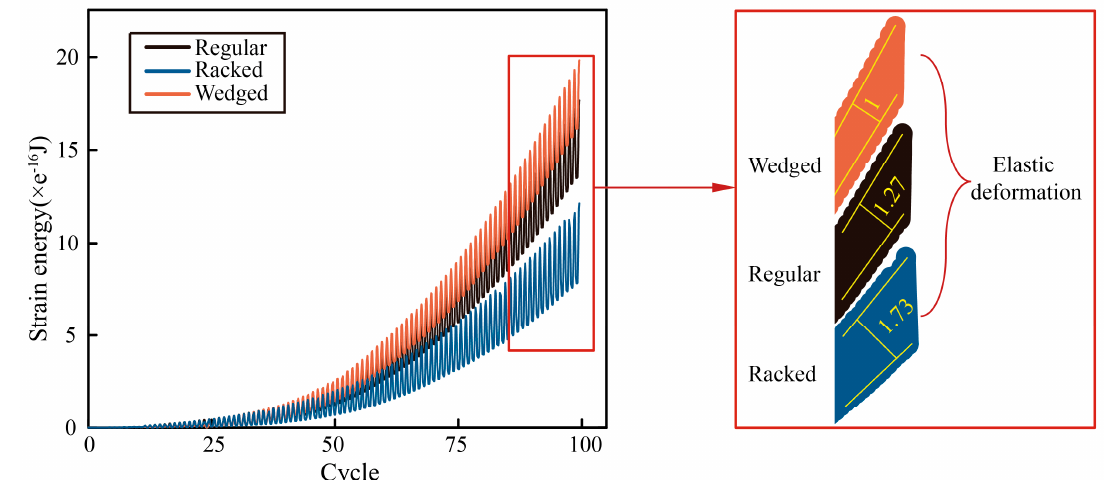
Figure 10. Strain energy of different morphological models.